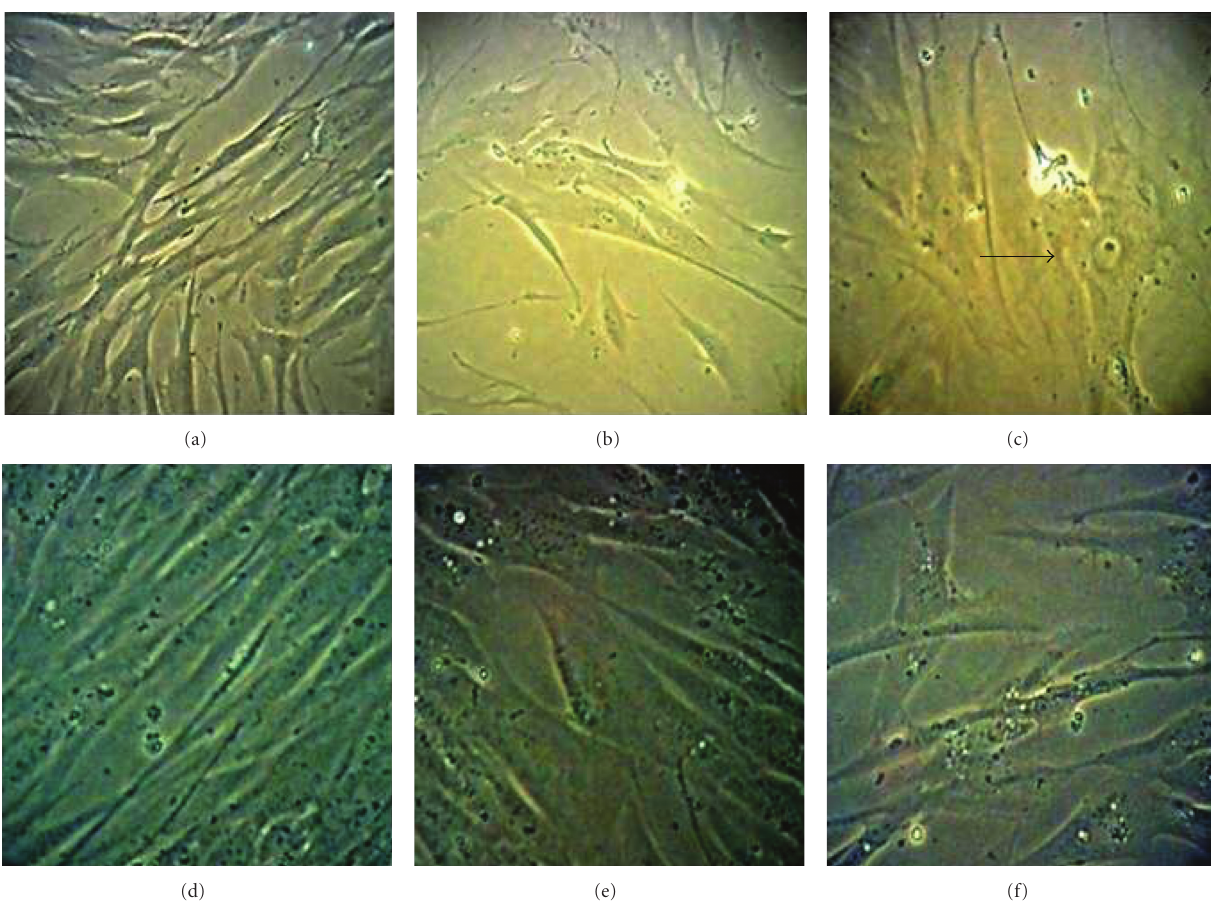
Figure 2: Morphological changes of HDFs in culture. Young (a), presenescent (b), and senescent (c) HDFs compared to TRF-treated HDFs (d)–(f). Senescent HDFs lost their original fibroblastic shape by acquiring a flattened morphology (indicated by arrow) with increased in size of nucleus and cells. The morphology of TRF-treated HDFs resembled that of young cells with more spindle-shaped cells present. Micrographs are shown at 200x